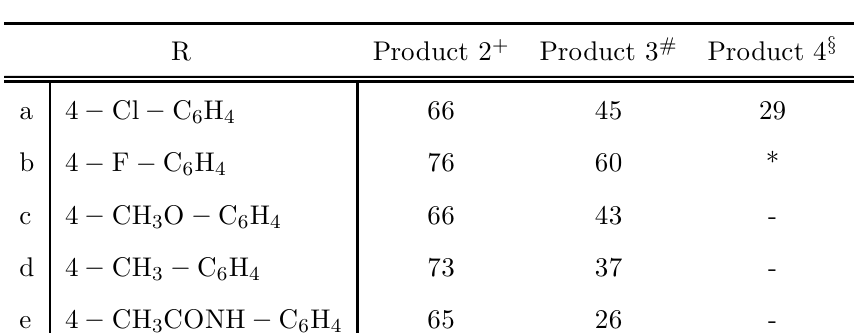
Table 1 Overview of reaction products yields (%). + Procedure A, # Procedure B, x Procedure C, ¤ detected only in a mixture with